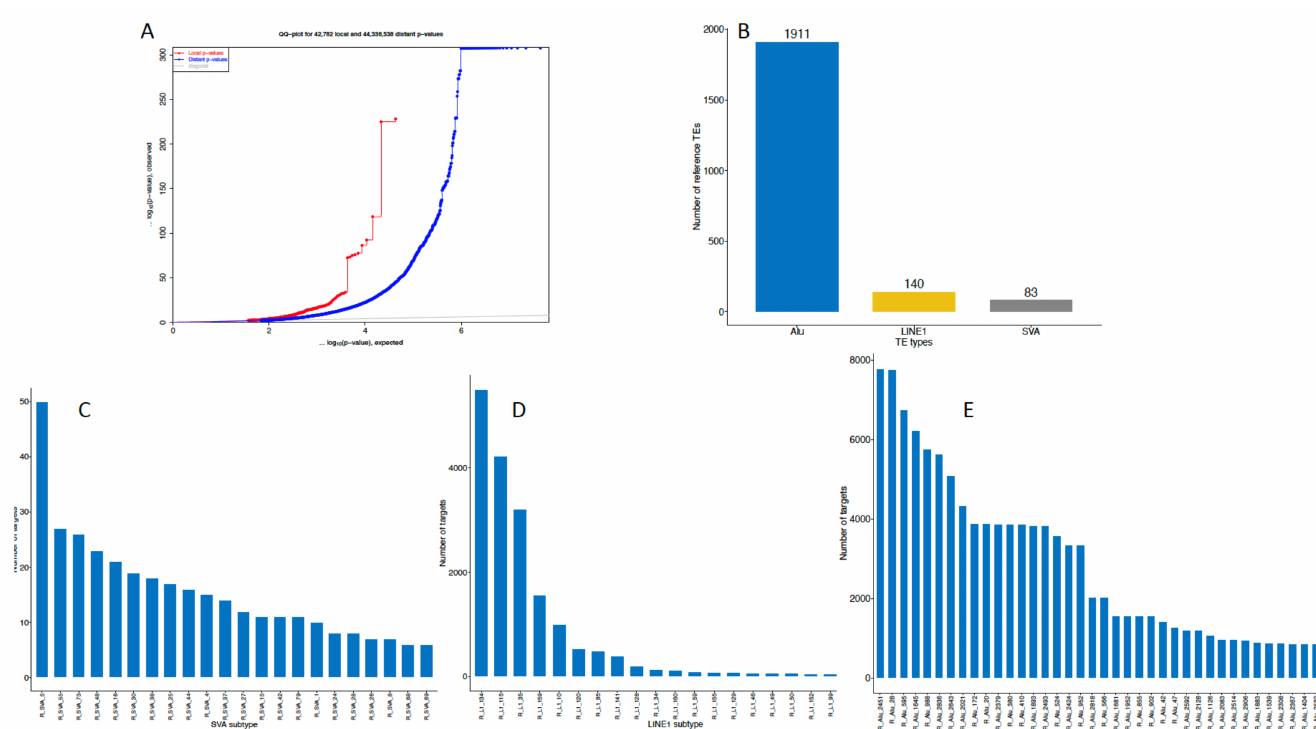
Figure 1. Summary statistical information about the analysed transposable elements (TEs). ( A ) is a Q-Q plot of identified p-values from eQTL analysis; ( B ) is a plot for all TE categories we analysed in our study. ( C – E ) are separate density plots for the eQTLs (targets) for SVA, L1 and Alu